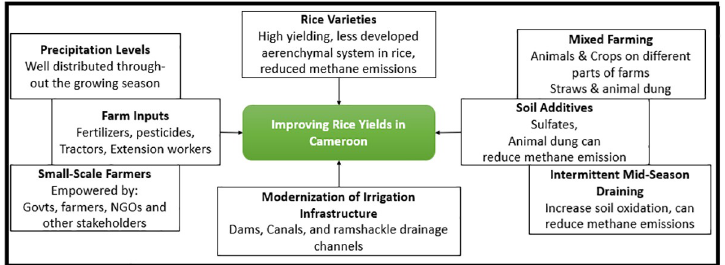
Fig 12. Schematic of options to improve rice yields in Cameroon. Source: Authors’ conceptualization.